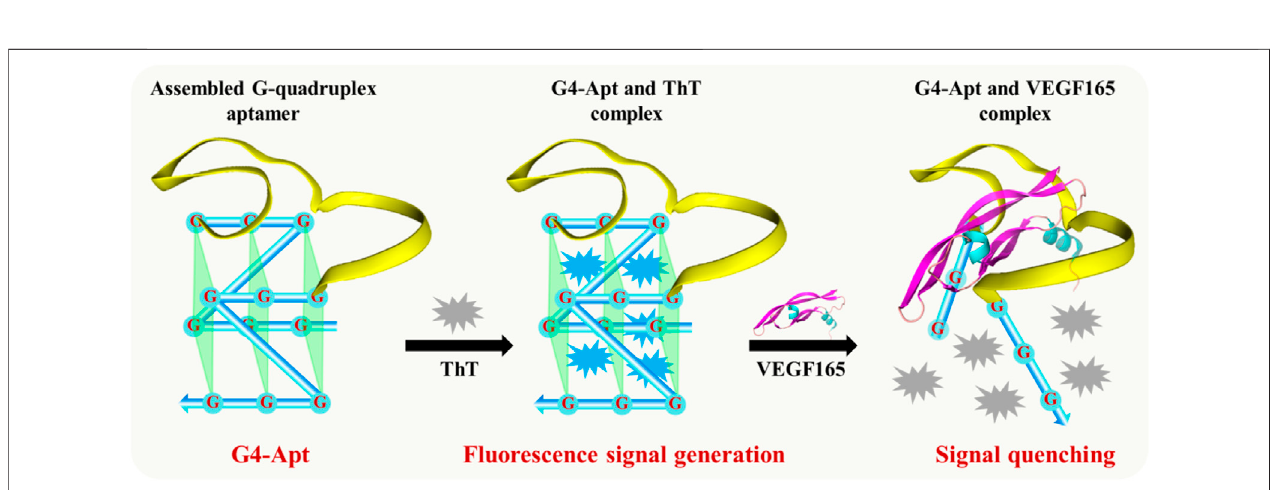
FIGURE 3 | Illustration of the developed fl uorescent aptasensor based on the assembled G-quadruplex aptamer and thio fl avin T (ThT).